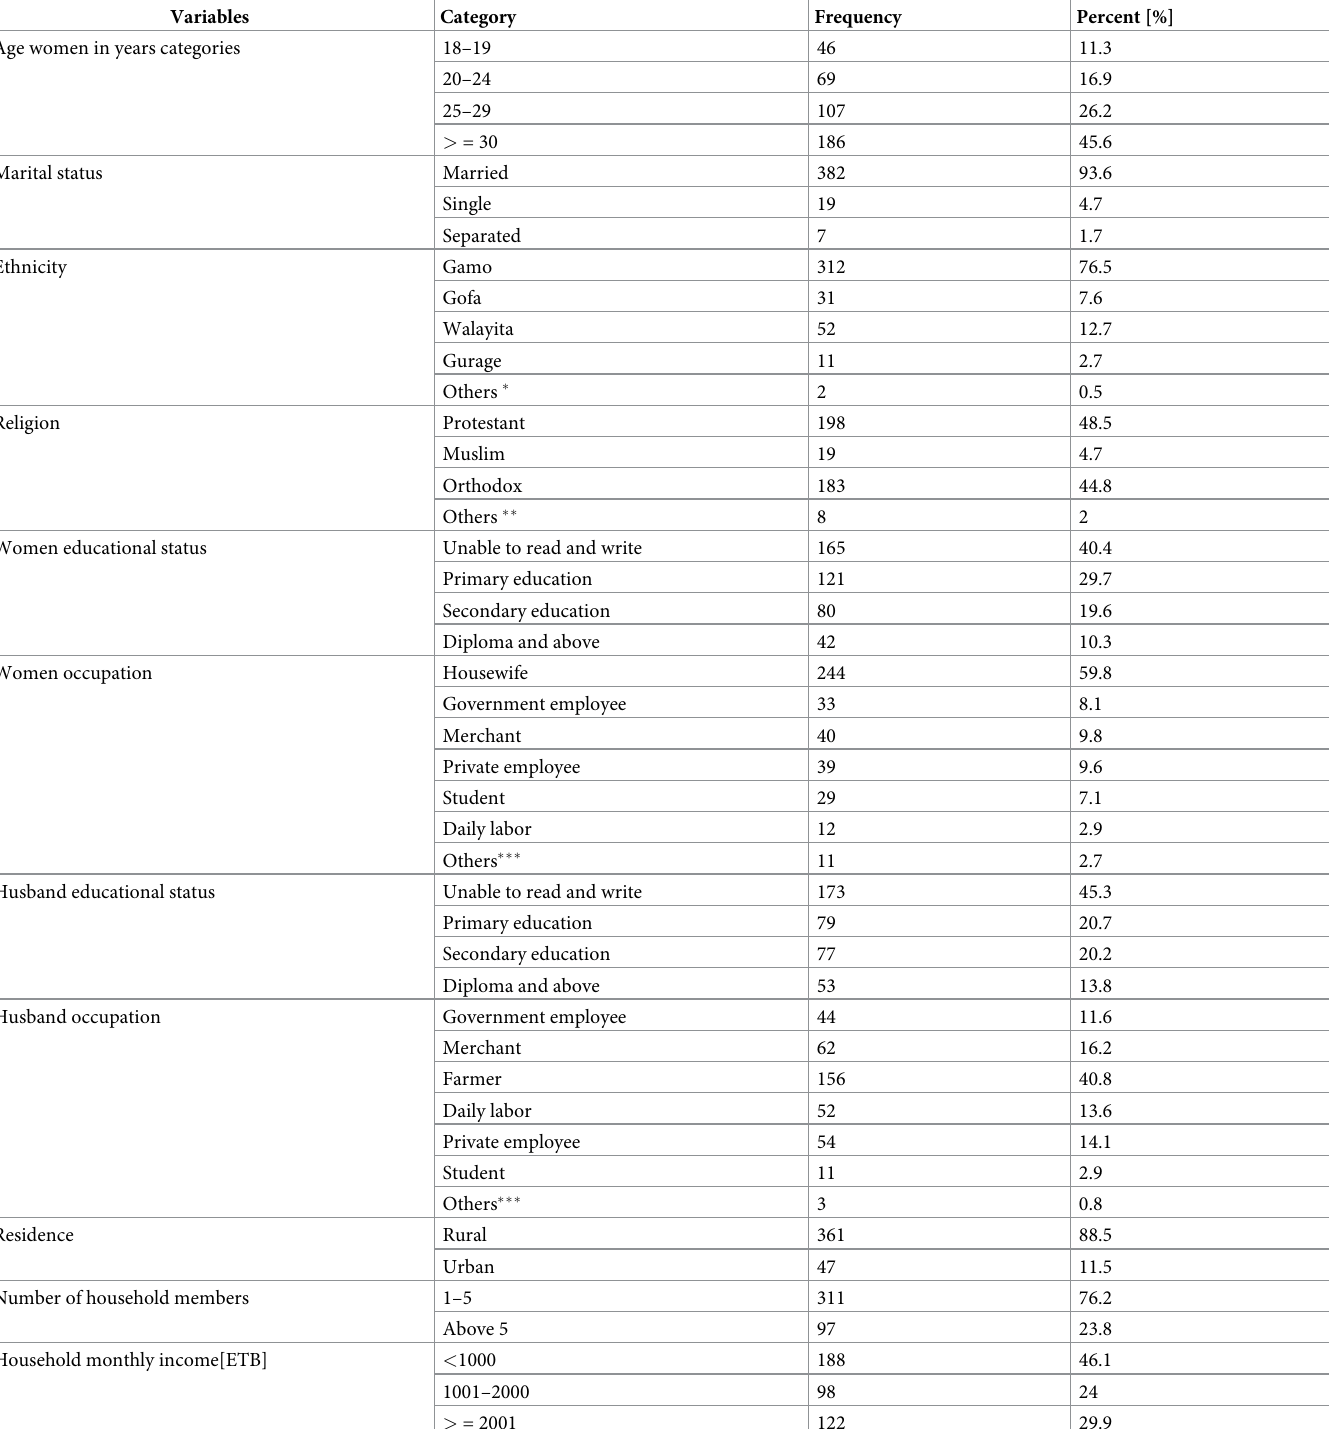
Table 1. Socio-demographic characteristics of the study participants in Arba Minch health demographic surveillance site in May